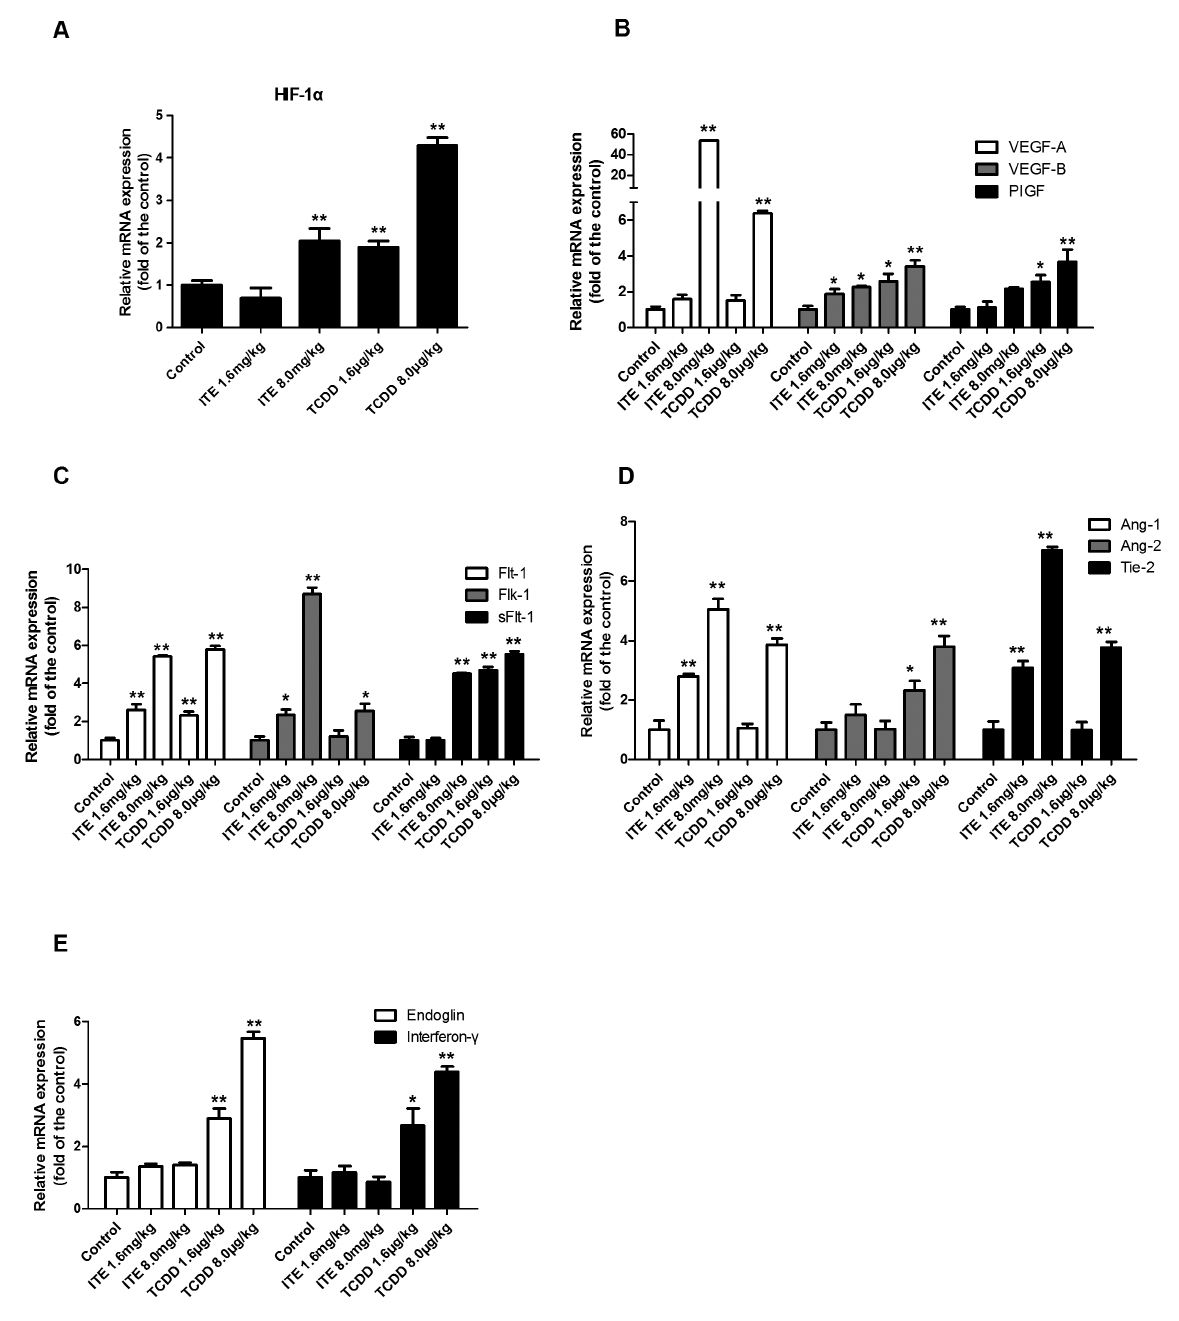
Figure 6. Effects of ITE and TCDD on mRNA expression of angiogenic-associated genes in placental tissues. The total RNA samples from placental tissues were subjected to real-time PCR. *Differ from the control ( p , 0.05), **differ from the control ( p , 0.001; n=4/group). Data are expressed as means 6 S.E.M fold of the control. fetal death by exposure to TCDD is possibly due to the reduced blood flow and alterations of vascular morphologies in the placental labyrinth zone. Moreover, we also hypothesized that endogenous AhR ligand ITE and the toxic ligand TCDD may modify the transcription of different sets of genes to account for their different toxicity.